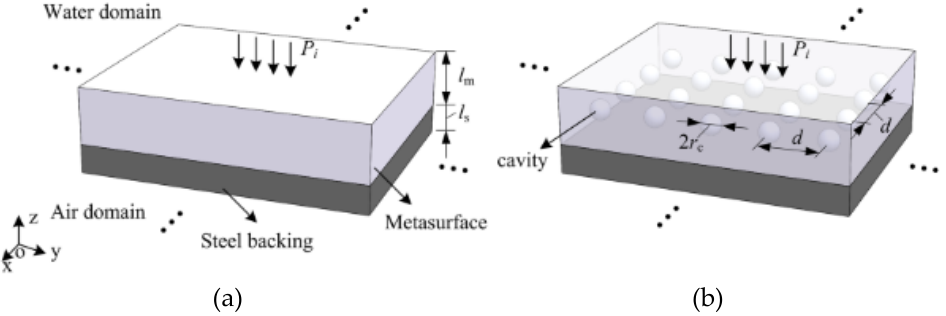
Figure 33. ( a ) A schematic view of an underwater absorptive metasurface with a finite-thickness steel plate followed by air; ( b ) A physical realization of the proposed metasurface for perfect absorption [100].